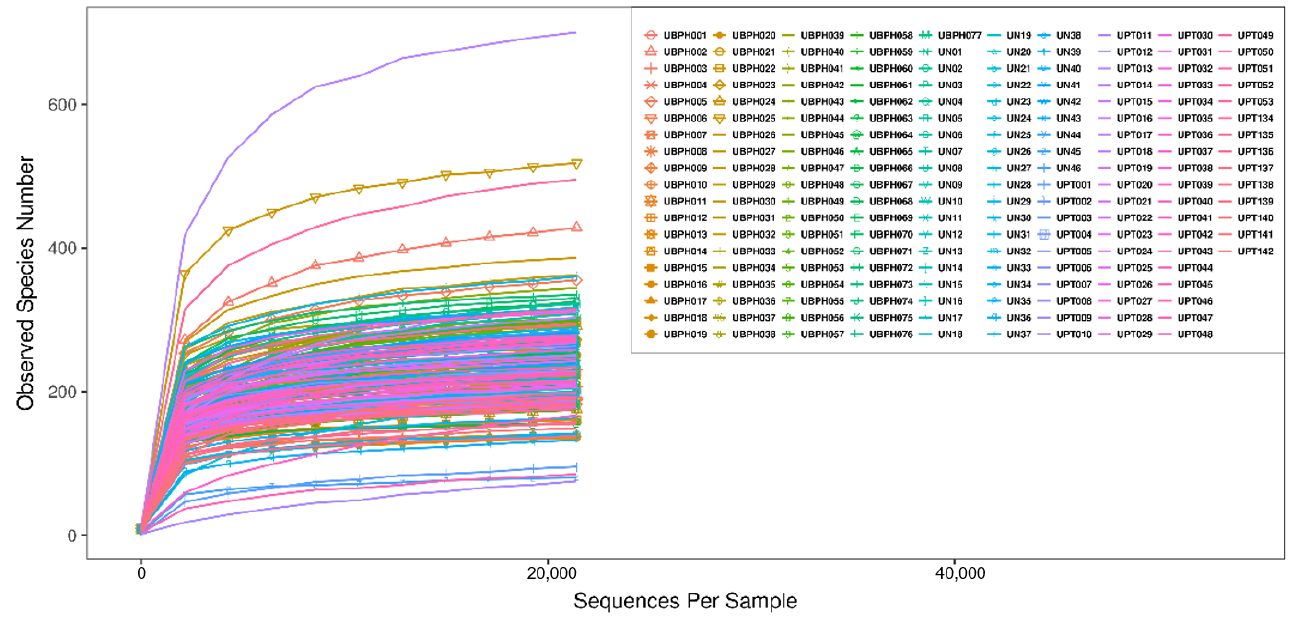
Figure 1. Rarefaction curve of stool samples. Sequence number threshold of the stool sample was set at 33,800. Each line represents a stool sample collected from a project participant. SBPH: Stool from a patient with BPH. SN: Stool from control group. SPT: Stool from a patient with prostate cancer.